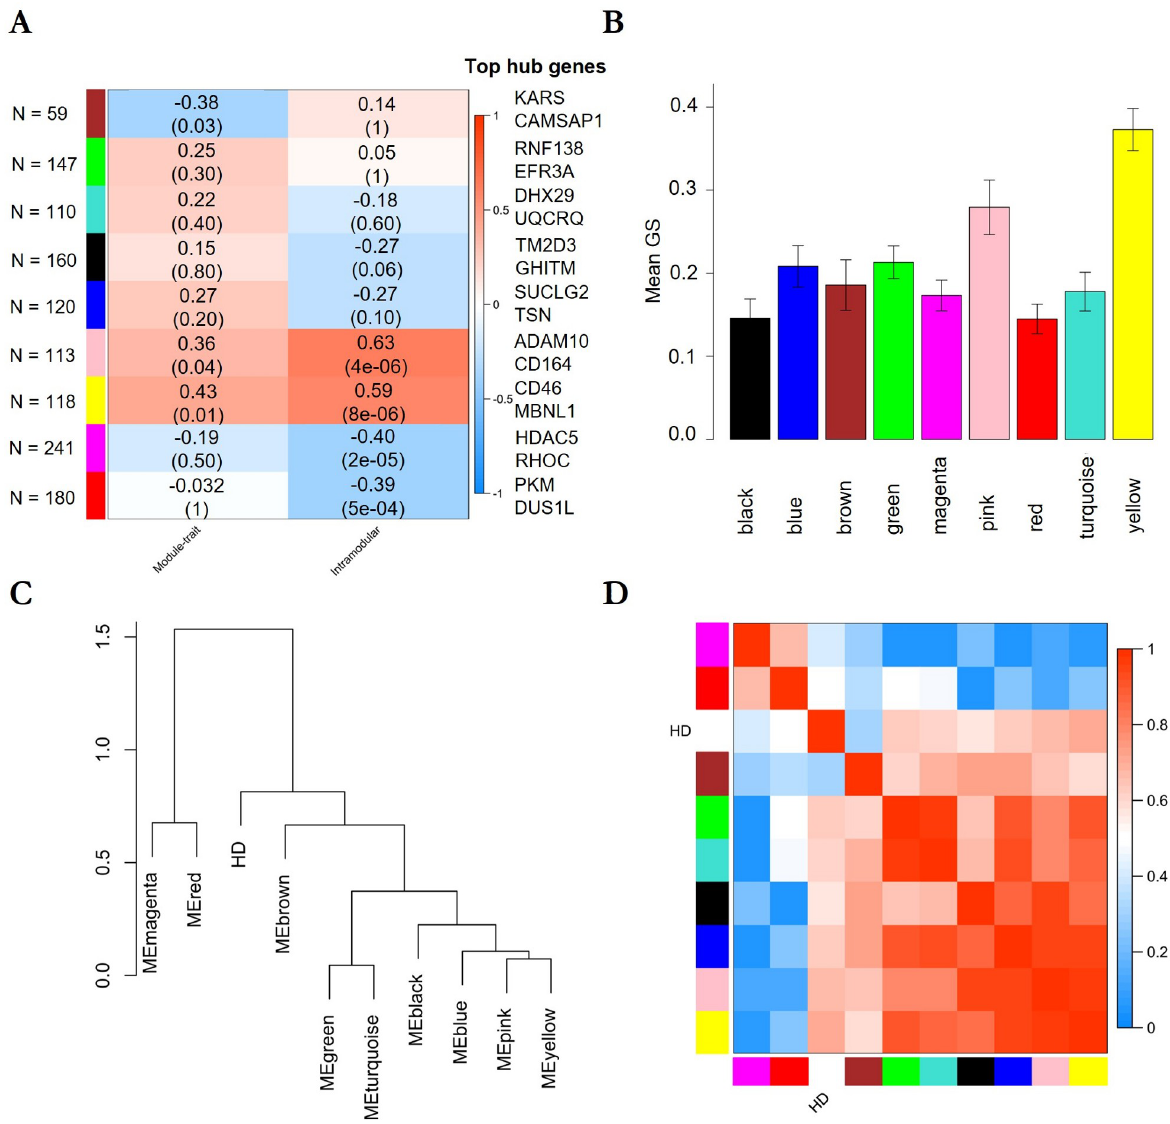
Fig 6. Result of WGCNA analysis and the association of the disease state with module eigengenes. A. Heatmap showing the correlation between module and disease state or between gene significance and module membership. A positive correlation between a module and disease state shows that the mRNA levels of genes belonging to this module were elevated in samples from HD patients and vice versa. P-values adjusted after Benjamini & Yekutieli (Yekutieli and Benjamini, 2001) are given in brackets. B: Mean gene significance of each module. Error bars depict the 95% confidence interval. C. Dendrogram showing hierarchical clustering of module eigengenes. D. Eigengene adjacency heatmap.